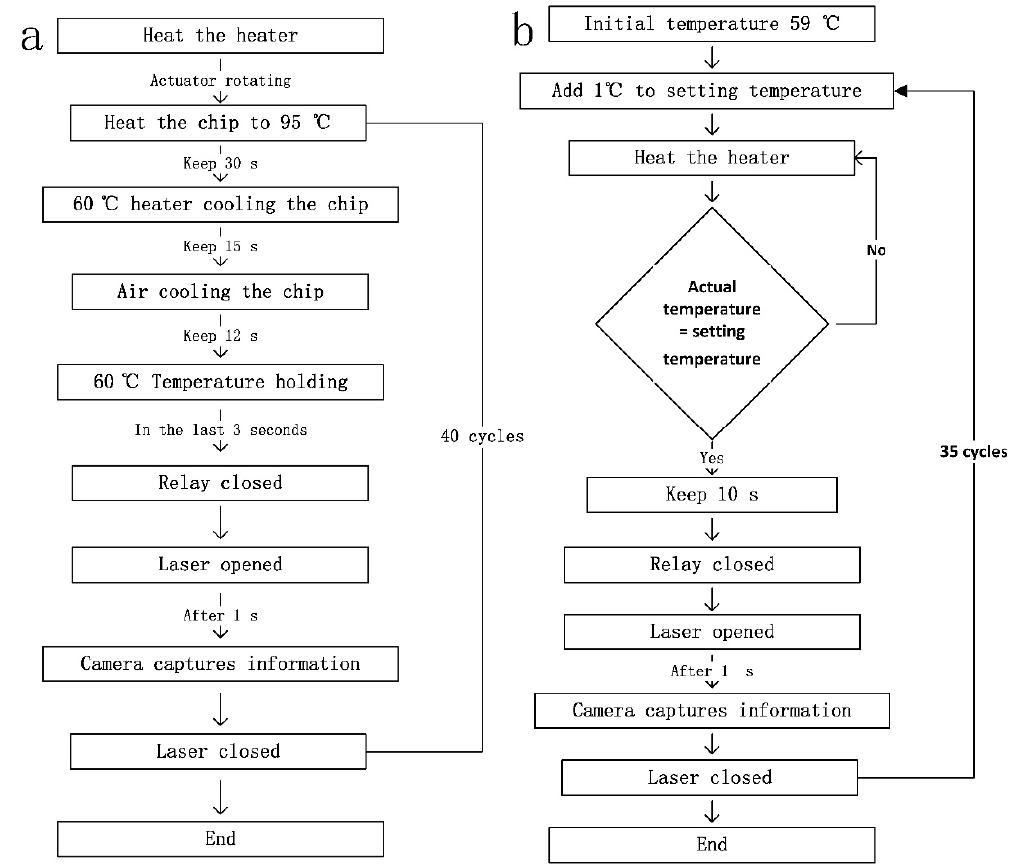
Figure 2. Diagram in mode 3 for the ( a ) amplification workflow and ( b ) the melting curve.